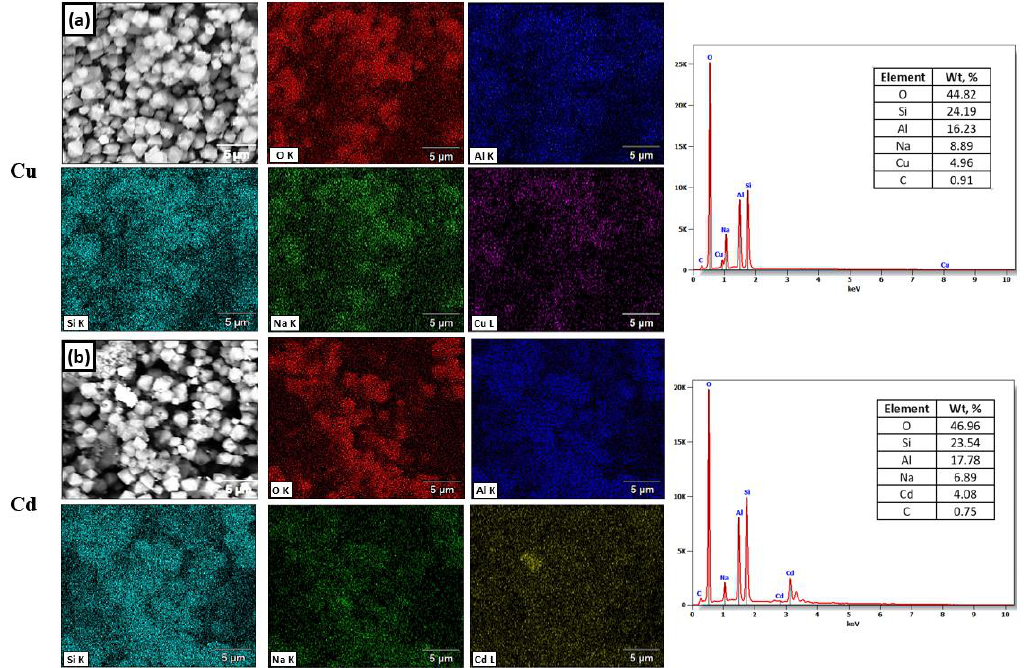
Figure 11. SEM image of the synthesized zeolite at SASR-Kaolin weight ratio of 1:1.5: ( a ) mapping of Cu 2+ loaded, O, Al, Si, Na, Cu, and EDS element analysis, ( b ) mapping of Cd 2+ loaded, O, Al, Si, Na, Pb, and EDS element analysis.